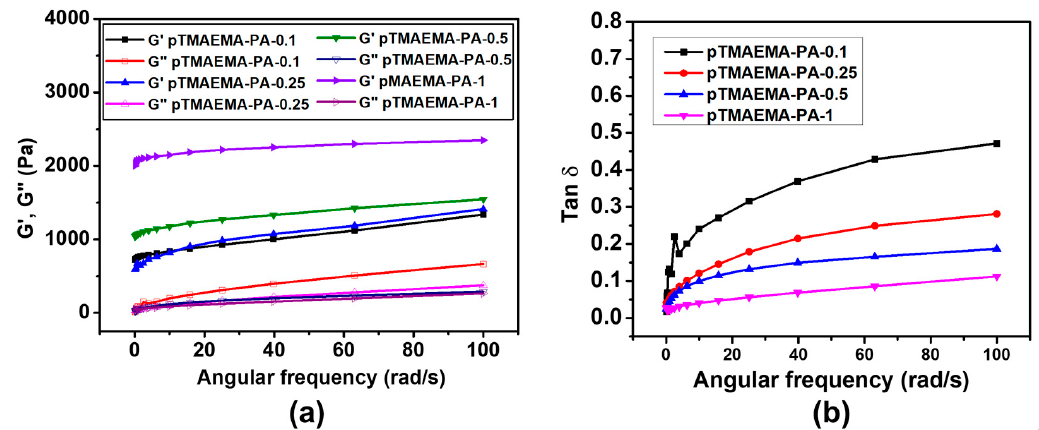
Figure 2. Dynamic mechanical behaviors of the pTMAEMA-PA hydrogels at a different loading concentration of phytic acid (PA): ( a ) angular frequency dependence of the storage modulus G ′ , loss modulus G ″ , and ( b ) loss factor tan δ .